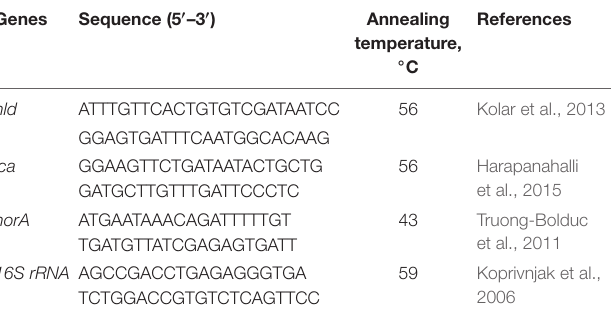
TABLE 1 | Primers used for the quantitative real-time reverse transcription–polymerase chain reaction assay. Genes Sequence (5 (cid:48) –3 (cid:48) ) Annealing